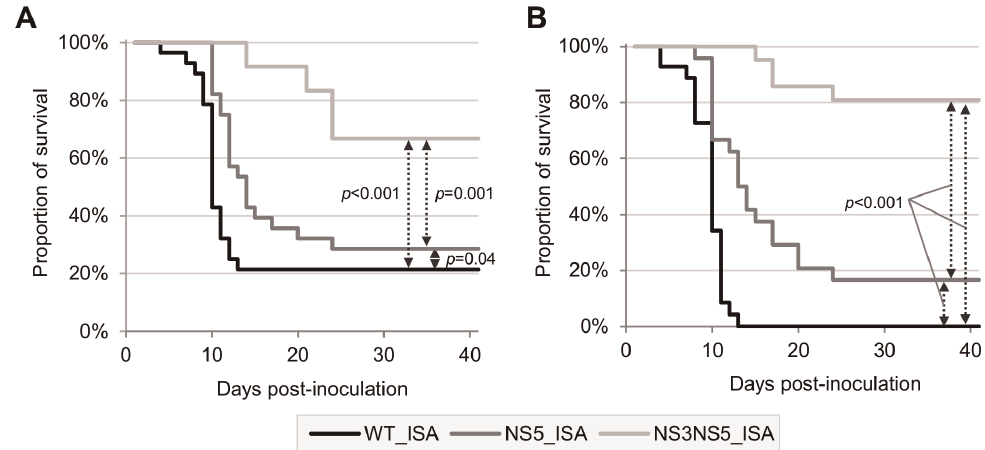
Fig 3. Kaplan-Meier survival analysis using as criteria, a weight loss of more than 6% (A) and appearance of at least one symptom (B).